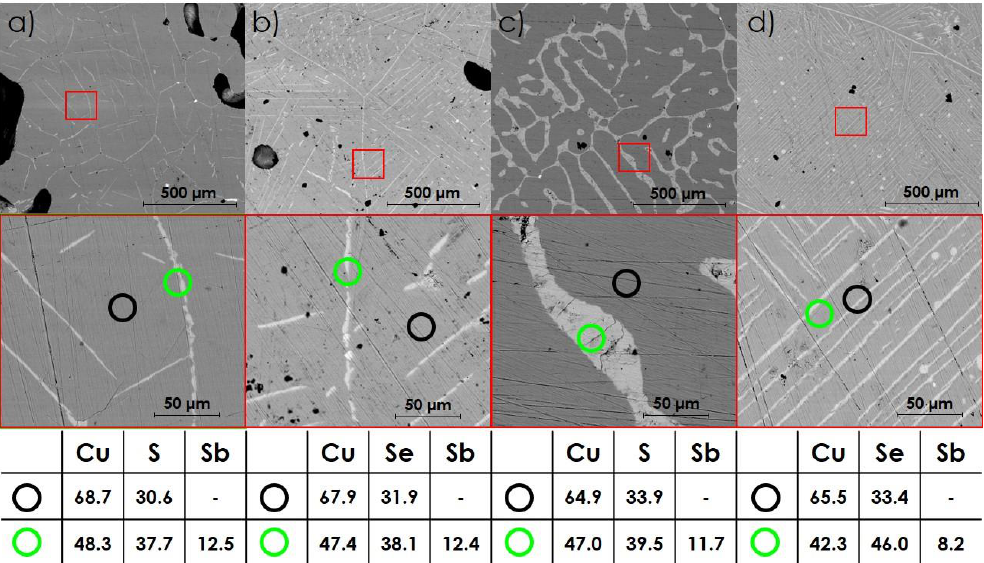
Figure 4. SEM micrographs together with the corresponding EDS point analysis (% at.): ( a ) CSS5, ( b ) CSS10, ( c ) CSE5, ( d ) CSE10. All data were collected from the fractured as-synthesized ingot.